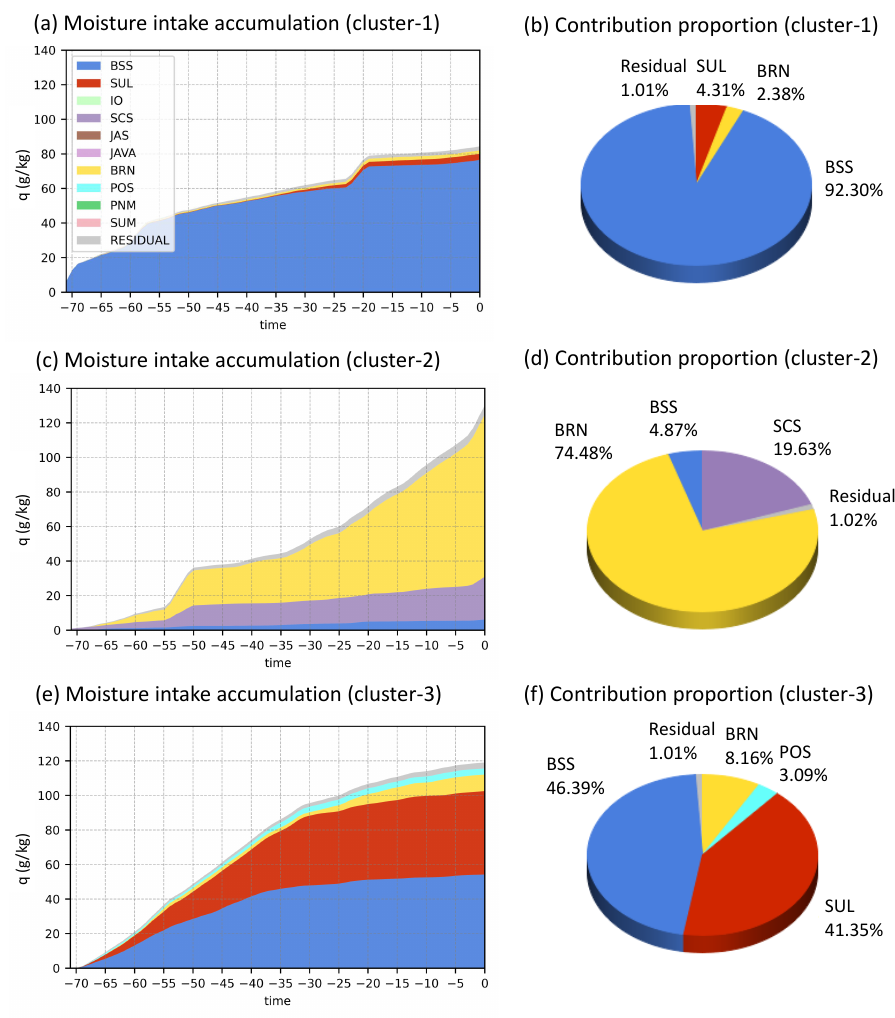
Figure 8. As in Figure 7b,c, but for the moisture intake in the three clusters. In Cluster 2, approximately 74.48% of the moisture was transported from BRN with a relatively steep pattern, indicating faster moistening of the air parcel along the pathways over this area. It is worth noting that because the release point of the trajectory is also located over BRN as well, this cluster indicates moisture recycling. Moisture is recycled when the evaporation over an area contributes to the precipitation over the same area in which the evaporation is closely related to vegetation and a catchment area over the area [45,46]. This cluster was crucial to the moisture source of the extreme rainfall event in Nusantara because BRN accounts for half of the total moisture sources (see Figure 7), and the specific humidity along the trajectory is relatively high (see Figure 5c). This high relative humidity can also be explained by the MCS analysis indicating the intensive cloud formation, thus representing moisture intake over BRN (see Figure 4). Over this cluster, the SCS, as the oceanic moisture source, contributes 19.63% of the total moisture intake of this cluster. Furthermore, in Cluster 3, the contribution between terrestrial (SUL and BRN) and oceanic (BSS) moisture sources is comparable (Figure 8f). Terrestrial moisture sources contributed 49.51% of the moisture sources, and oceanic moisture sources contributed 46.39% of the moisture sources. The pattern shows that moisture intake increased at a nearly linear rate over this cluster (see Figure